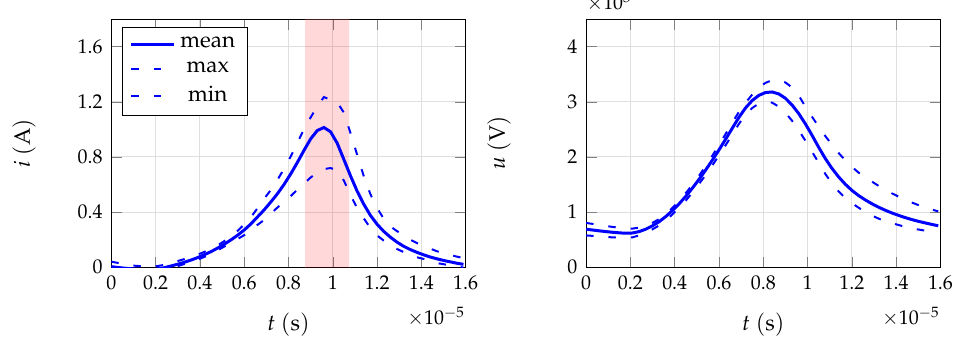
Figure 6. Typical voltage and current traces recorded for a frequency of 60 kHz and a power setting of 100 %. The trigger timeframe at which the experimental setup was triggered is marked in the current plot.